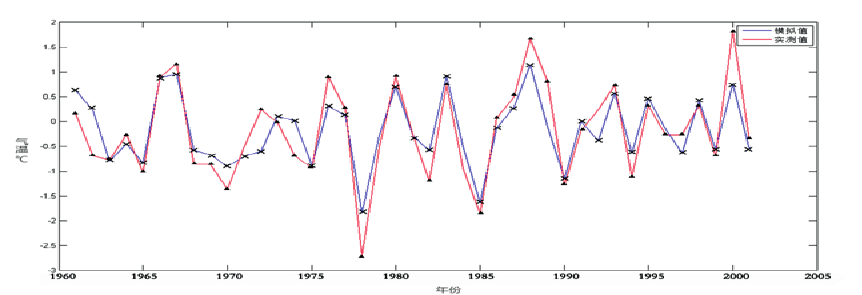
Fig. 3 Optimal temperature simulation based on developed GA.